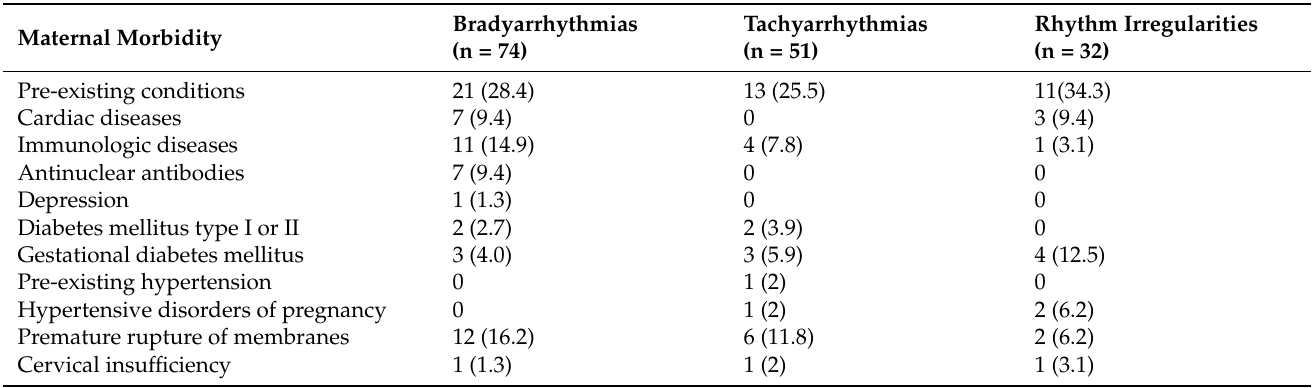
Table 5. Maternal morbidity: Pre-existing conditions and gestational complications in women with fetal